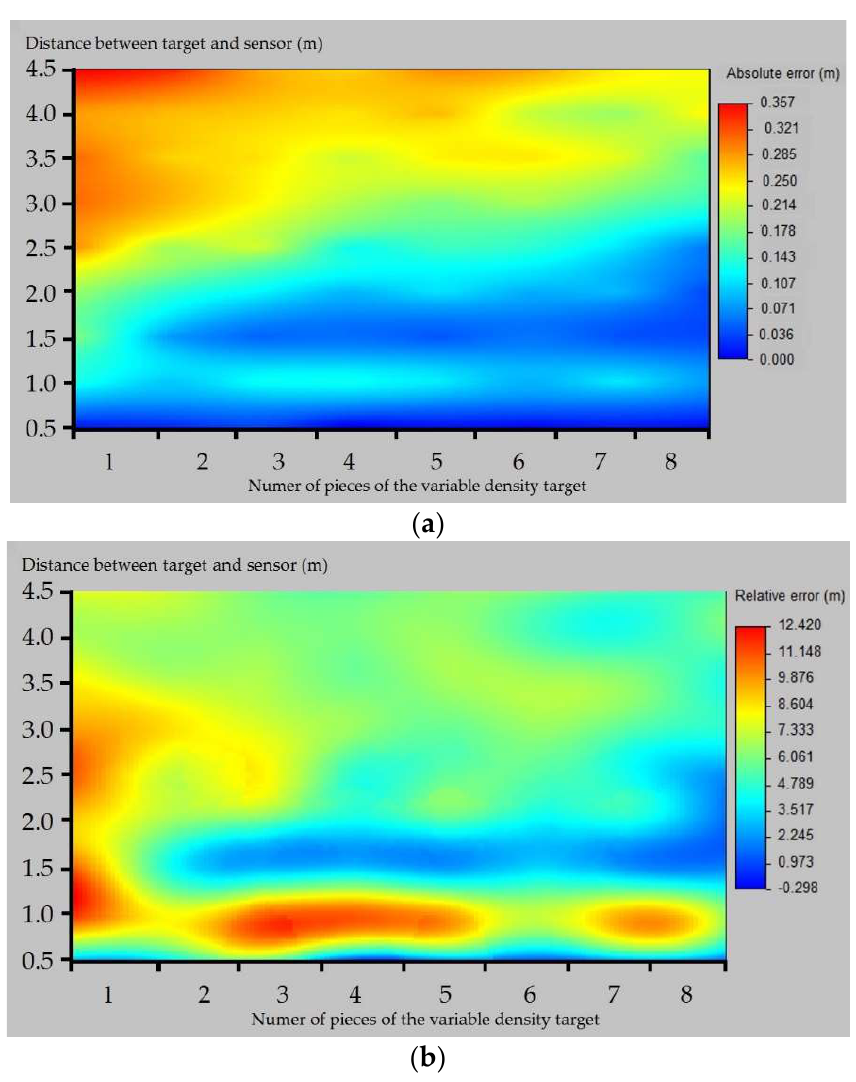
Figure 10. Average ( a ) absolute and ( b ) relative errors with density-varying target.